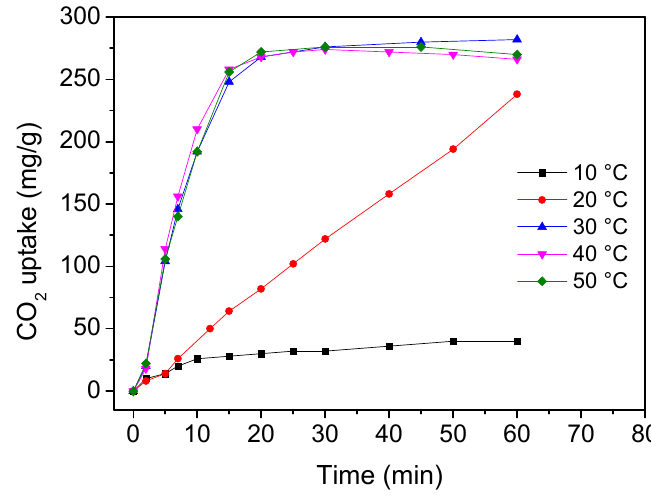
Figure 5. CO 2 sorption kinetics of HSCP-70 at different temperatures.